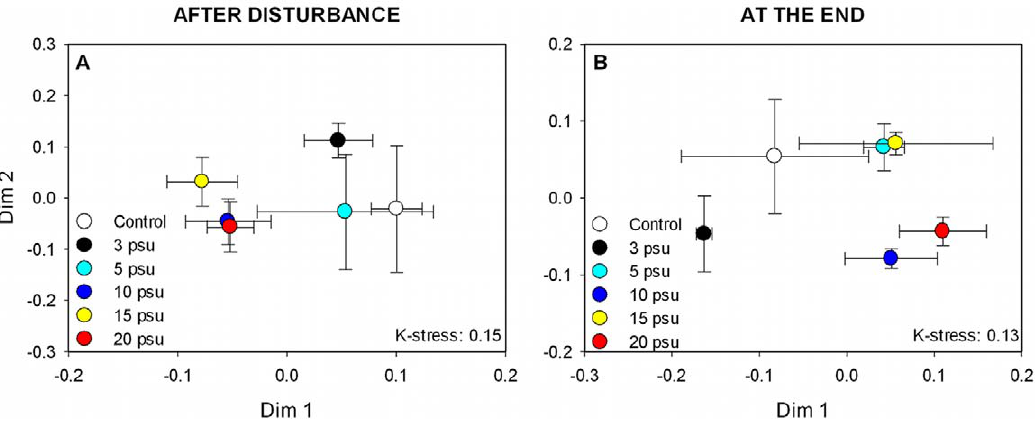
Figure 1. NMDS plots showing the changes in BCC in relation to disturbance intensity (Experiment 1). NMDS are based on Bray-Curtis distances according to bacterial community composition patterns (t-RFLP), after the disturbance (A) and at the end of the experiment (B). Error bars indicate standard errors.